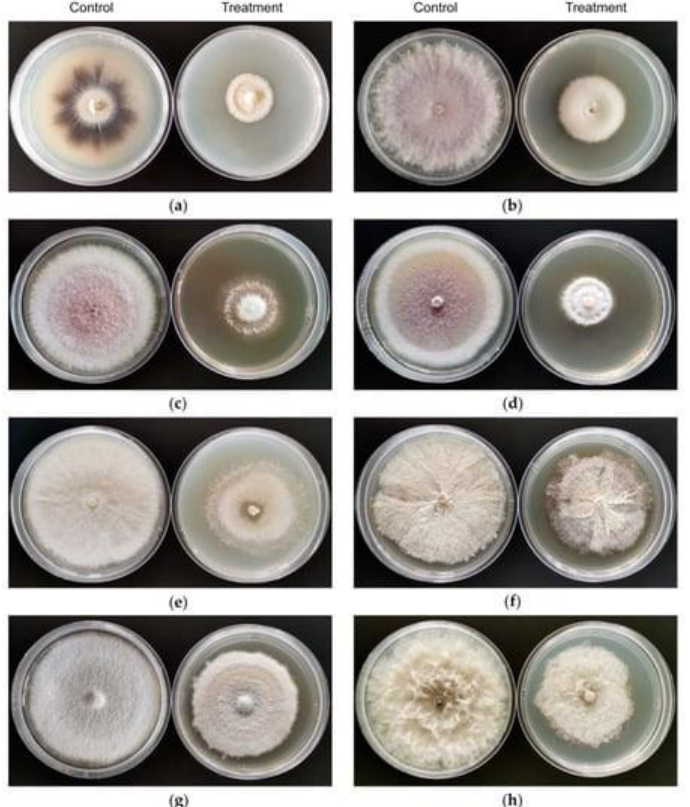
Figure 3. Effect of VOCs emitted by strain CT32 on the growth of 8 phytopathogenic fungi in vitro. In the sealed plates test, fungi in the control groups were cultured on potato dextrose agar (PDA) medium. The mycelial growth of fungi in the treatment groups was suppressed upon exposure to volatiles emitted by strain CT32. ( a ) V. dahliae ; ( b ) F. oxysporum f. sp. fragariae ; ( c ) F. oxysporum, f. sp. niveum ; ( d ) F. oxysporum, f. sp. cucumerinum ; ( e ) B. cinerea ; ( f ) T. cucumeris ; ( g ) G. cingulata ; ( h ) B. dothidea . Adapted from Li et al., 2020 [69].